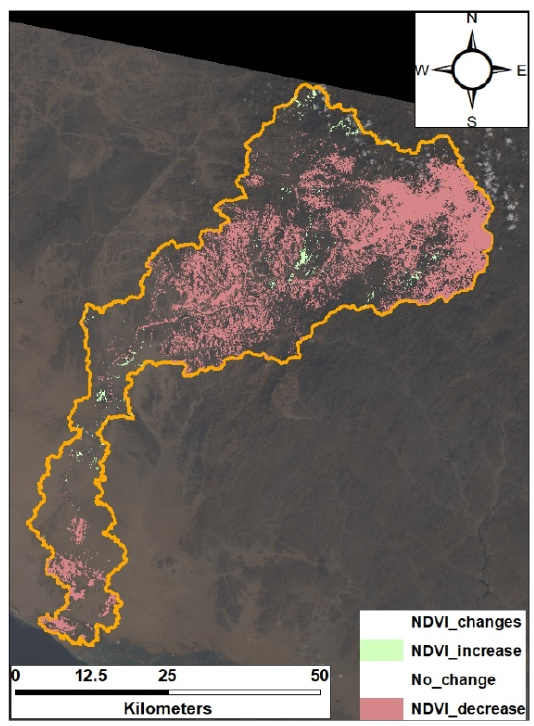
Figure 11. NDVI thematic change detection map within the study